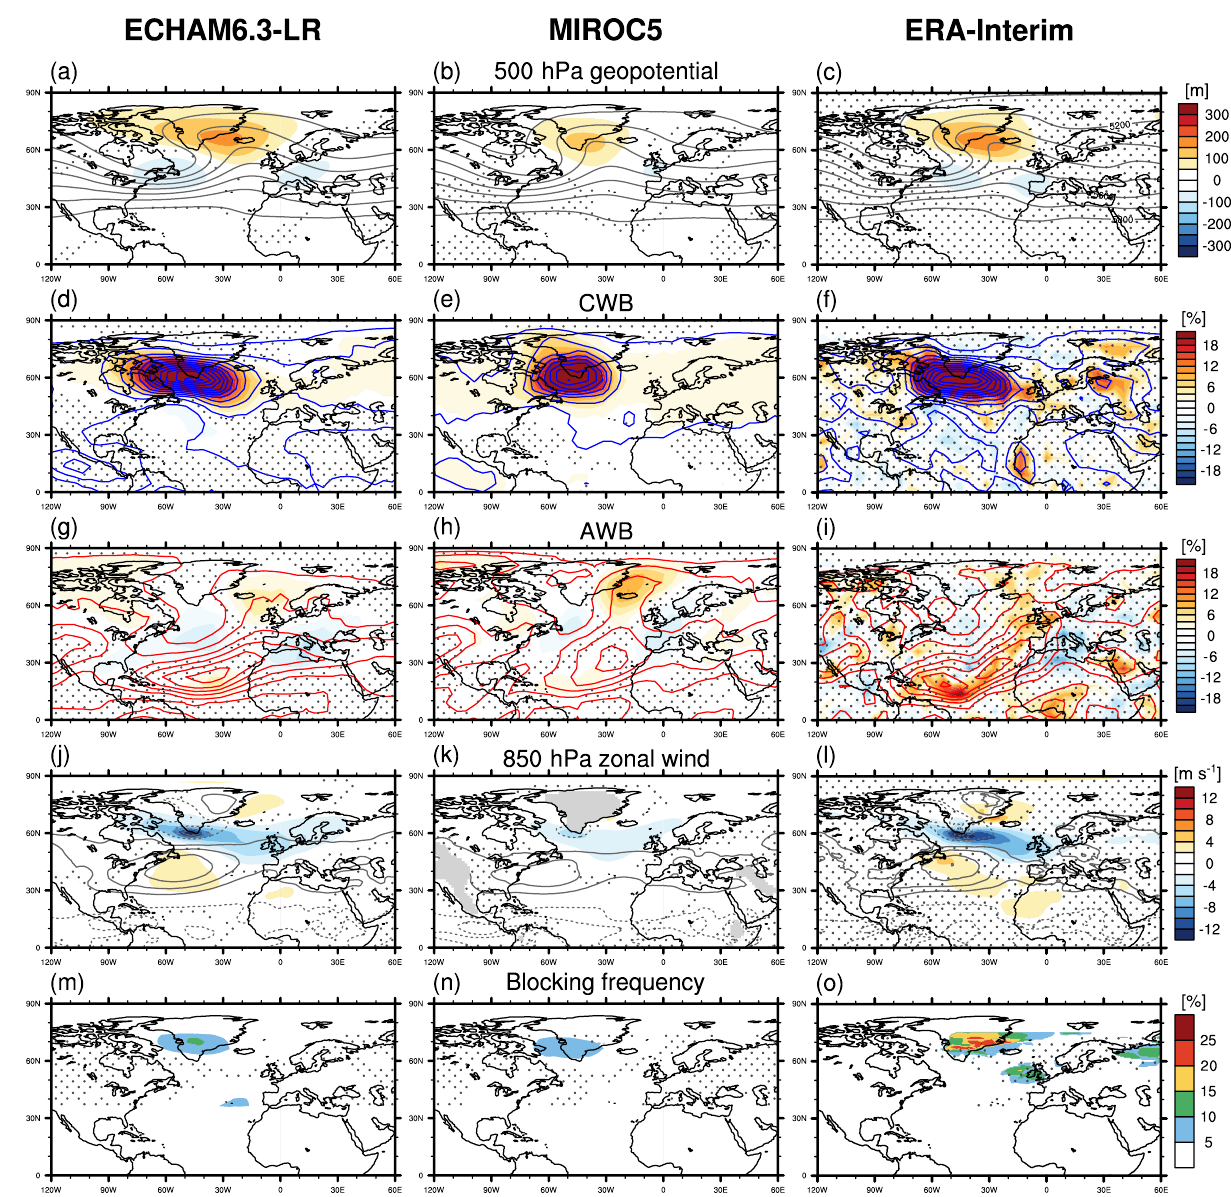
Figure 6. Ensemble means of the circulation anomalies during CWB days for (left) ECHAM6.3-LR, (centre) MIROC5, and (right) ERA- Interim. (a, b, c) 500hPa geopotential (contours are drawn every 100m from 5000 to 6000m) and anomalies (shading, in m). (d, e, f) Cyclonic wave breaking frequency (first contour and interval: 5%) and anomalies (shading, in %). (g, h, i) Same as (d) , (e) , and (f) but for anticyclonic wave breaking frequency. (j, k, l) Zonal wind at 850hPa (first contour and interval: 4ms − 1 , zero contour omitted, and dashed contours for negative values) and anomalies (shading, in ms − 1 ). (m, n, o) Blocking frequency (unit: fraction of the time with CWB). Dotted areas are not significant at the 10% level, with the significance calculated using a bootstrap method. For ERA-Interim, the AWB and CWB frequency fields (contours) have been smoothed for better